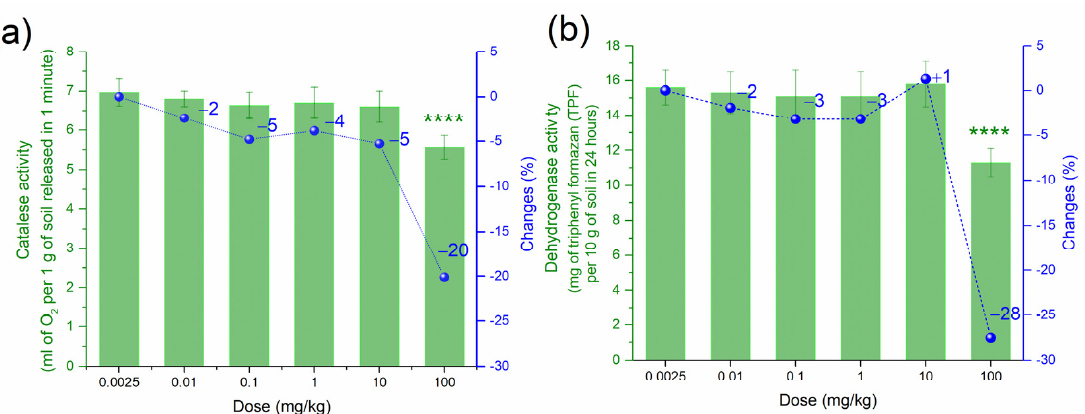
Figure 1. Effect of PtNPs on the enzymatic activity of Haplic Cambisols Eutric ( a ) catalase activity and ( b ) dehydrogenases activity with their relative changes compared to the control. (**** p ≤